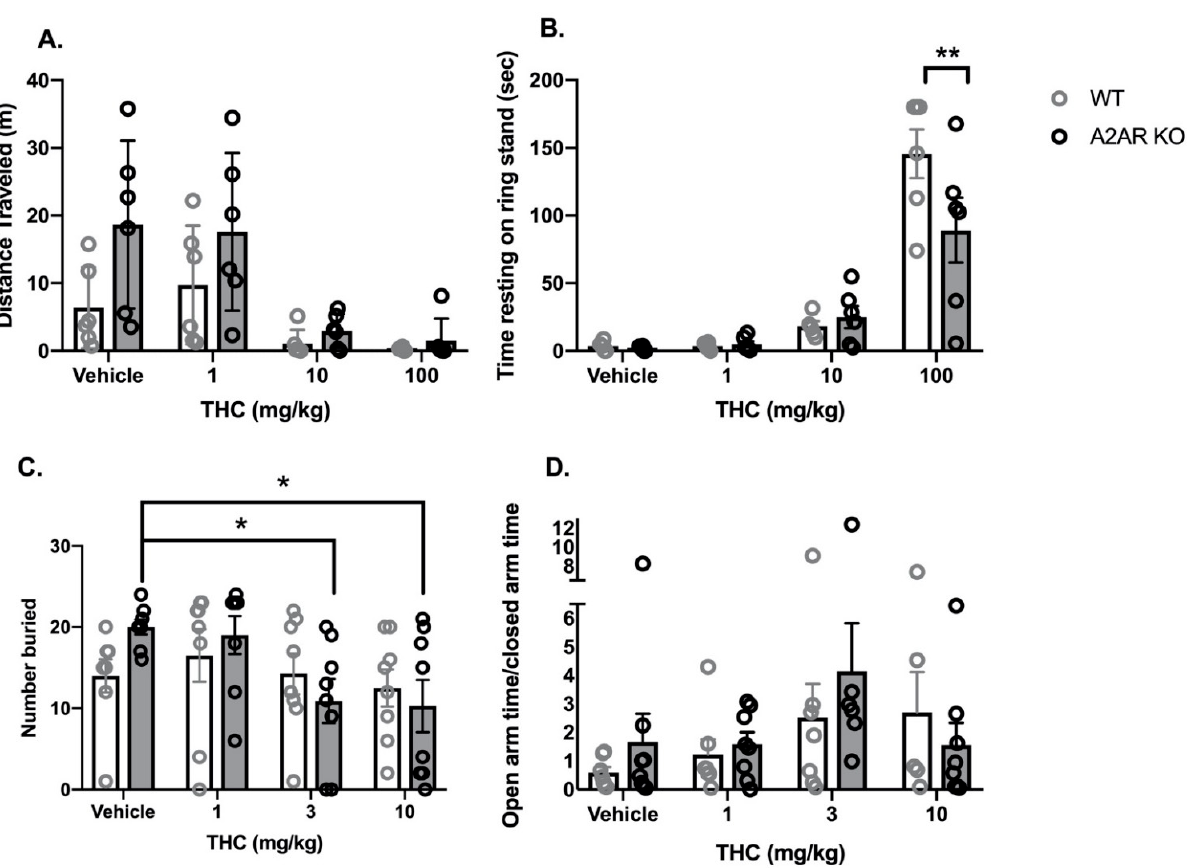
Figure 1. Comparison of some behavioral effects of THC in wild type (WT, open bars and gray symbols) and A2AR null (A2AR-KO, closed bars and black symbols) mice. ( A ) Effects of THC on locomotor activity in an open field. Mice were placed into a circular field for 15 min, and the distance moved was determined. ( B ) Effects of THC on cataleptic behavior in the ring stand assay. Sidak’s multiple comparison test was used to compare all groups to each other. ( C ) Effects of THC on the number of marbles buried. Dunnett’s multiple comparison test was used to compare each drug group to the vehicle control. ( D ) Effects of THC on the ratio of time spent in the open and closed arms of the EPM. A total of 8 mice were removed from this analysis because they entered the open arm and became immobile (1 mouse each from the WT/vehicle, WT/1 mg/kg, WT/3 mg/kg groups; 3 from the WT/10 mg/kg group and 2 from the KO/3 mg/kg group). Bars represent the mean, and vertical lines are the standard error of the mean. * p < 0.05 and ** p < 0.01.